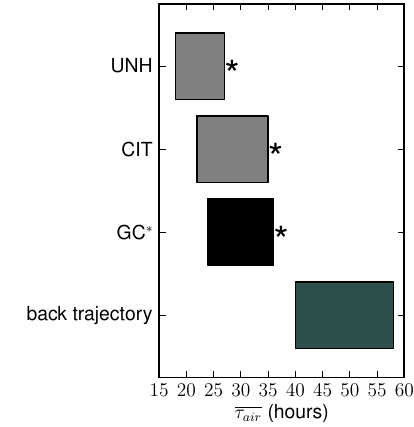
Fig. A5. Estimated mean air parcel lifetimes ( τ air ) derived from back trajectory and chemical simulation. Chemical simulations use our updated GEOS-Chem mechanism with the adjusted HNO 3 , the unadjusted CIT measurement, or the UNH unadjusted measure- ment. Asterisks indicate whether chemically simulated NO x :HNO 3 is statistically consistent with observations ( α < 0 . 01) when using the exponential (left, Eq. 3) and bias-corrected (right, Eq. 4) statis- tical